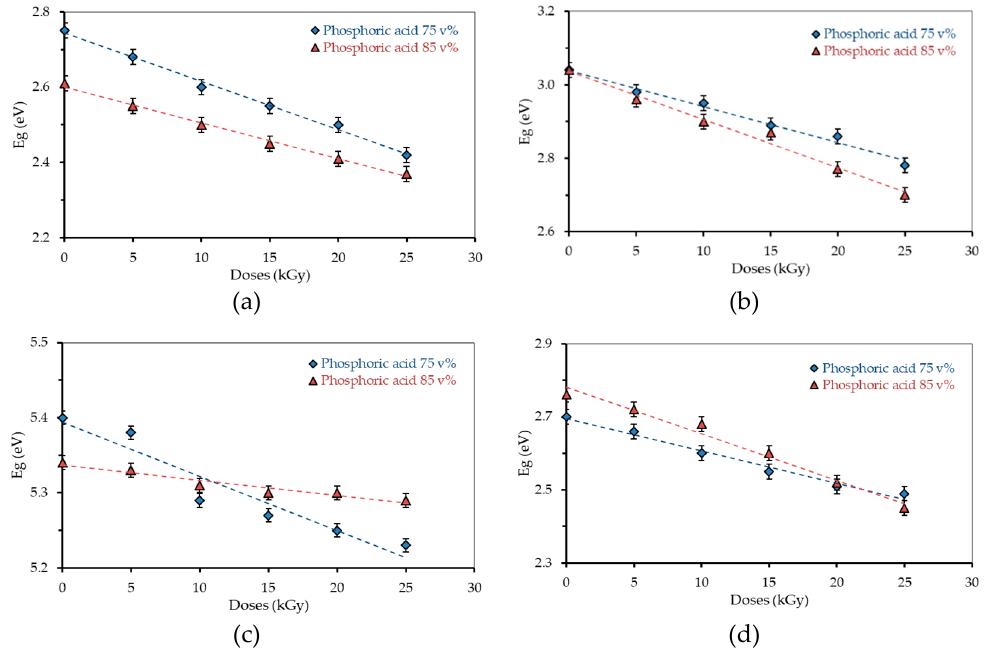
Figure 8. Energy gap at various concentrations and radiation doses: ( a ) the allowed direct transition ( α h υ ) 1/2 ; ( b ) the allowed indirect transition ( α h υ ) 2 ; ( c ) the forbidden direct transition ( α h υ ) 3/2 ; and ( d ) the forbidden indirect transition ( α h υ ) 1/3 .